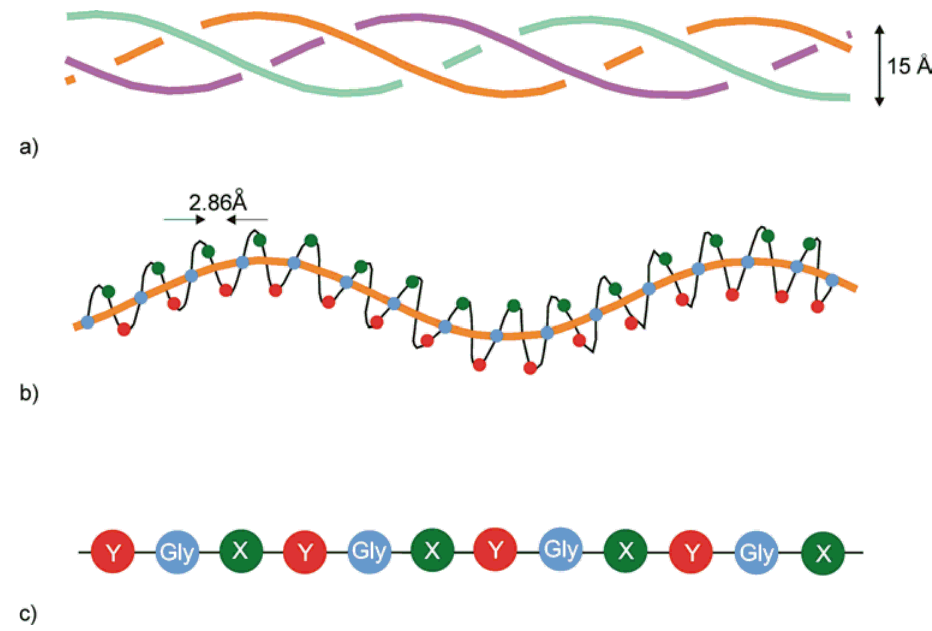
FIGURE 1. (a) The collagen triple helix. This helix is characterised by the right-handed intertwining of three polypeptide α -chains of pitch 9.5Å. (b) Each α -chain forms a left-handed helix with every third residue located in the centre of the triple helix. Here there is only space for glycines, the smallest amino acids, and there is hydrogen-bonding between the three chains. Therefore the amino acid sequence of the α -chain is characterised by the Gly-X-Y repeat (c) , with X and Y being often proline and hydroxyproline